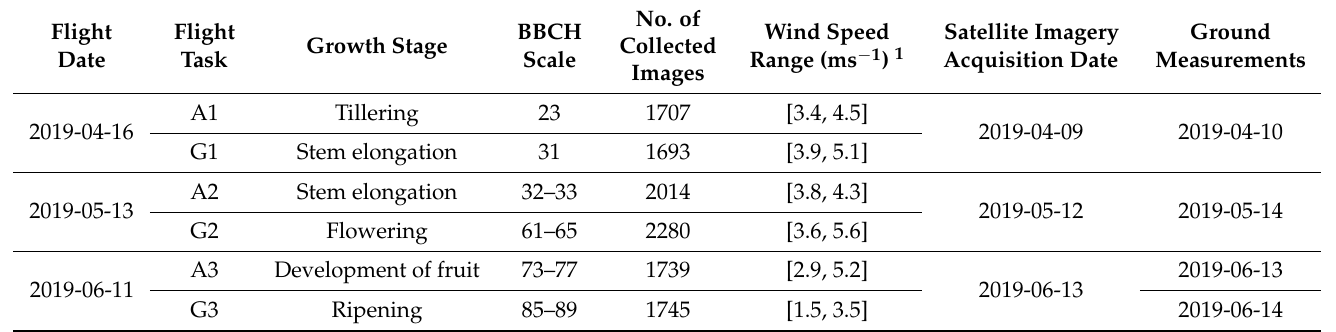
Table 2. Dates of flight campaigns, satellite acquisition and reference sampling in combination with plant growth and wind